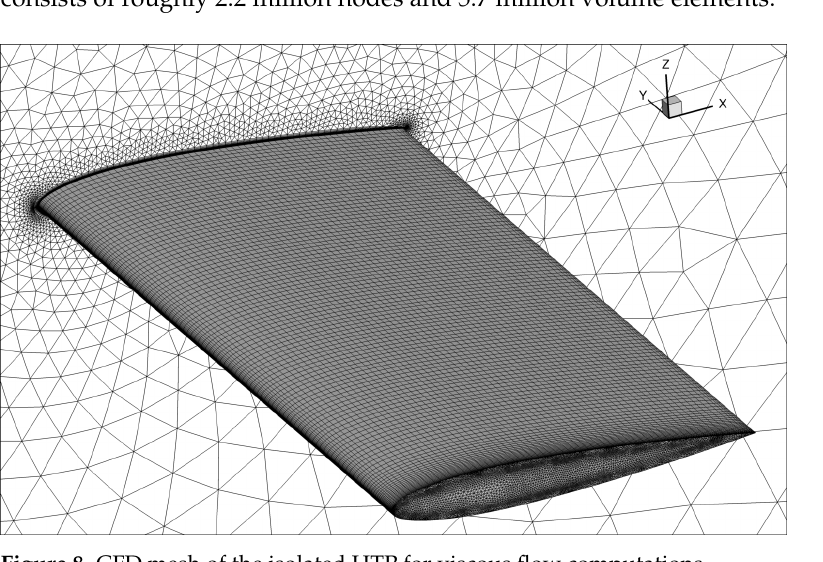
Figure 8. CFD mesh of the isolated HTP for viscous flow